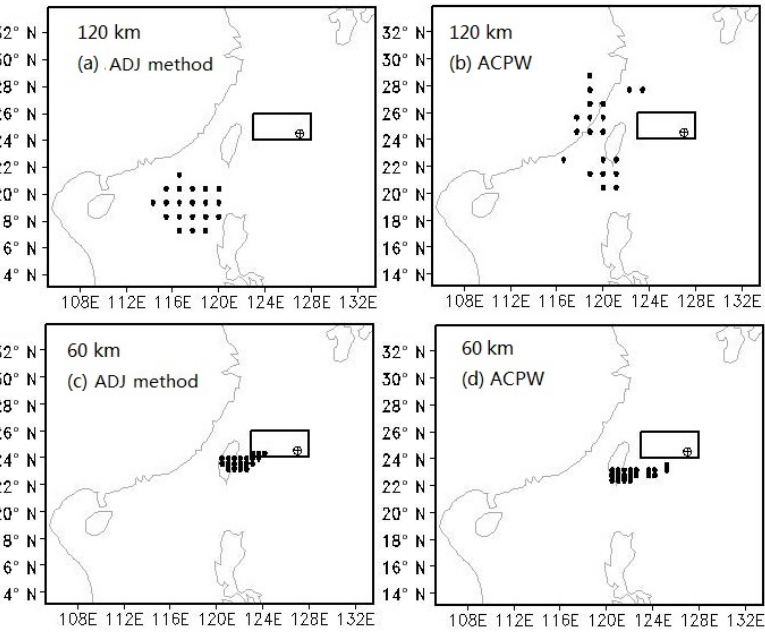
Figure 11. Sensitive regions identified by the CNOPs with 20 points for TC Fitow. The squares indicate the verification areas, and the initial cyclone positions are shown as ⊕ . Letters (a) and (b) denote the CNOP patterns at the 120km resolution for the ADJ method and the ACPW algorithm, respectively, while letters (c) and (d) represent the CNOP patterns at the 60km resolution for the ADJ method and the ACPW algorithm,